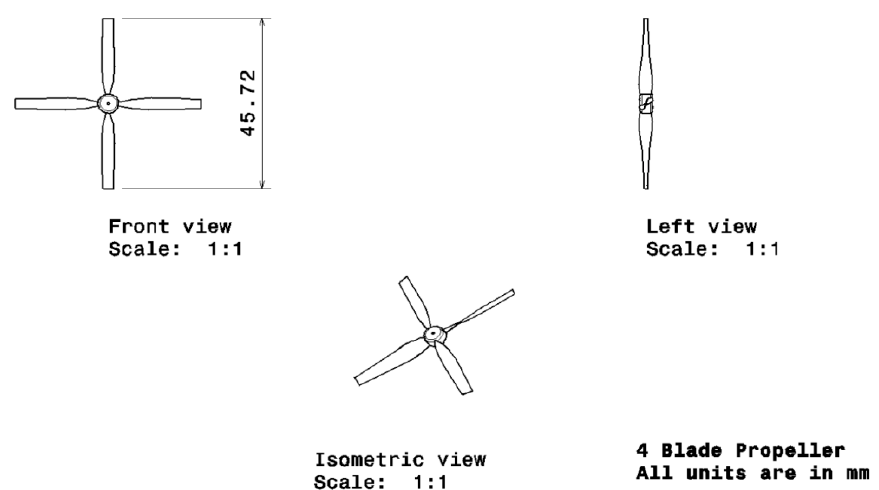
Figure 3. Design of selected UAV’s Propeller.